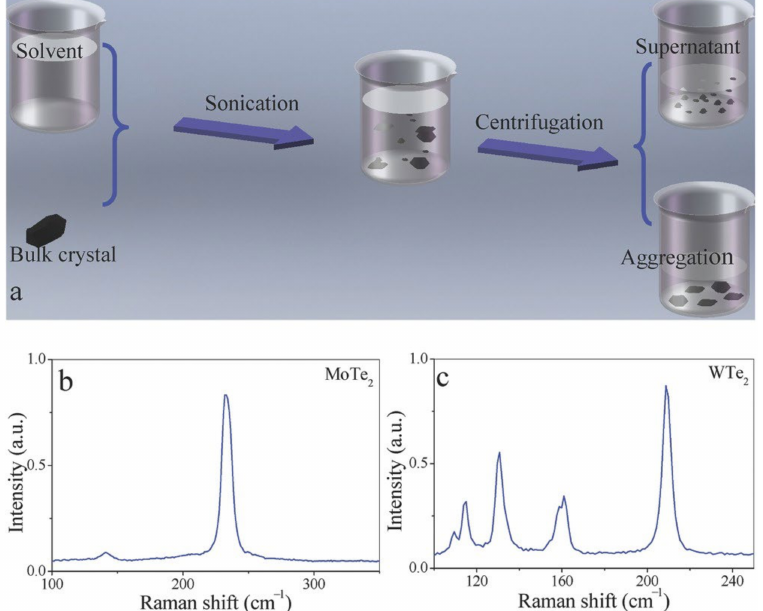
Figure 2. ( a ) Schematic diagram of a liquid exfoliation method for preparing MoTe 2 /WTe 2 nanosheets. Raman spectra of ( b ) bulk MoTe 2 and ( c ) bulk WTe 2 . Reprinted with permission from [49].